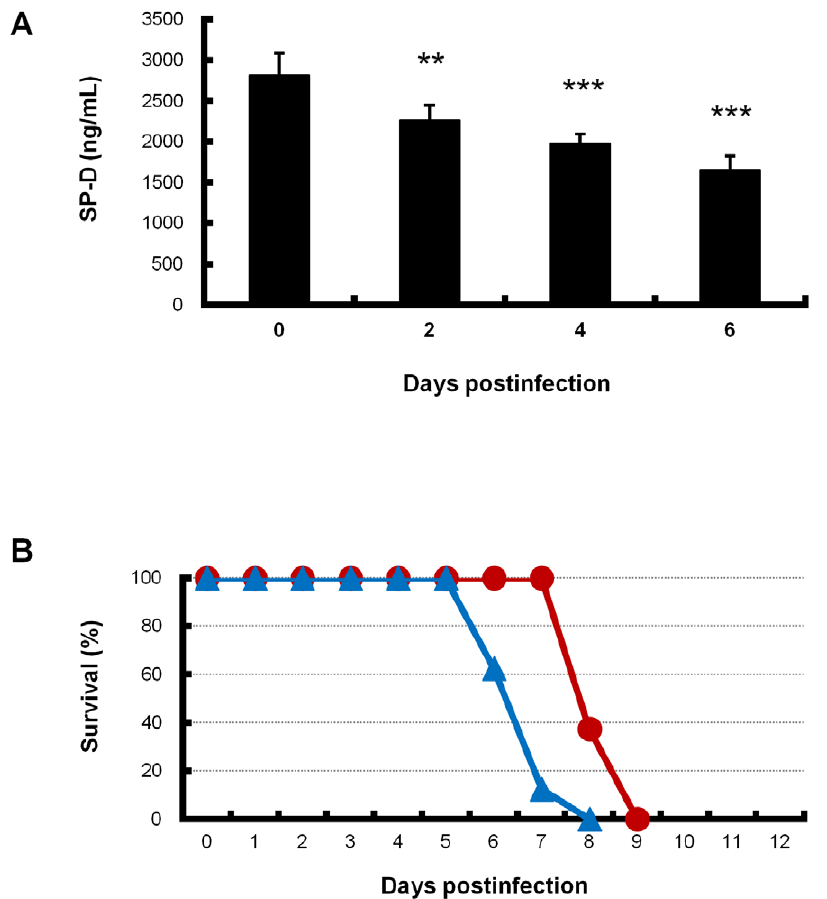
Figure 1. SP-D levels in infected lungs and survival of infected mice treated with artificial surfactant. (A) SP-D levels in lung homogenates from mice infected with the middle dose (5 MLD 50 ) of PR8 virus were measured by ELISA. Infected mice were sacrificed at the indicated days, and then clarified lung homogenates ( n =5 or 6) were used. Differences in means 6 SD and p values are shown. ** p , 0.01, *** p , 0.001. (B) Survival curves of infected mice administered artificial surfactant are shown. Mice infected with a low dose (2 MLD 50 ) of PR8 virus were additionally administered artificial surfactant ( n =8, red line) or normal saline solution ( n =8, blue line) intranasally once daily during 3–8 days postinfection. Significant differences in the survival rates of groups of mice treated with artificial surfactant or normal saline solution were analyzed by the log-rank original method. Percentage survival is shown.